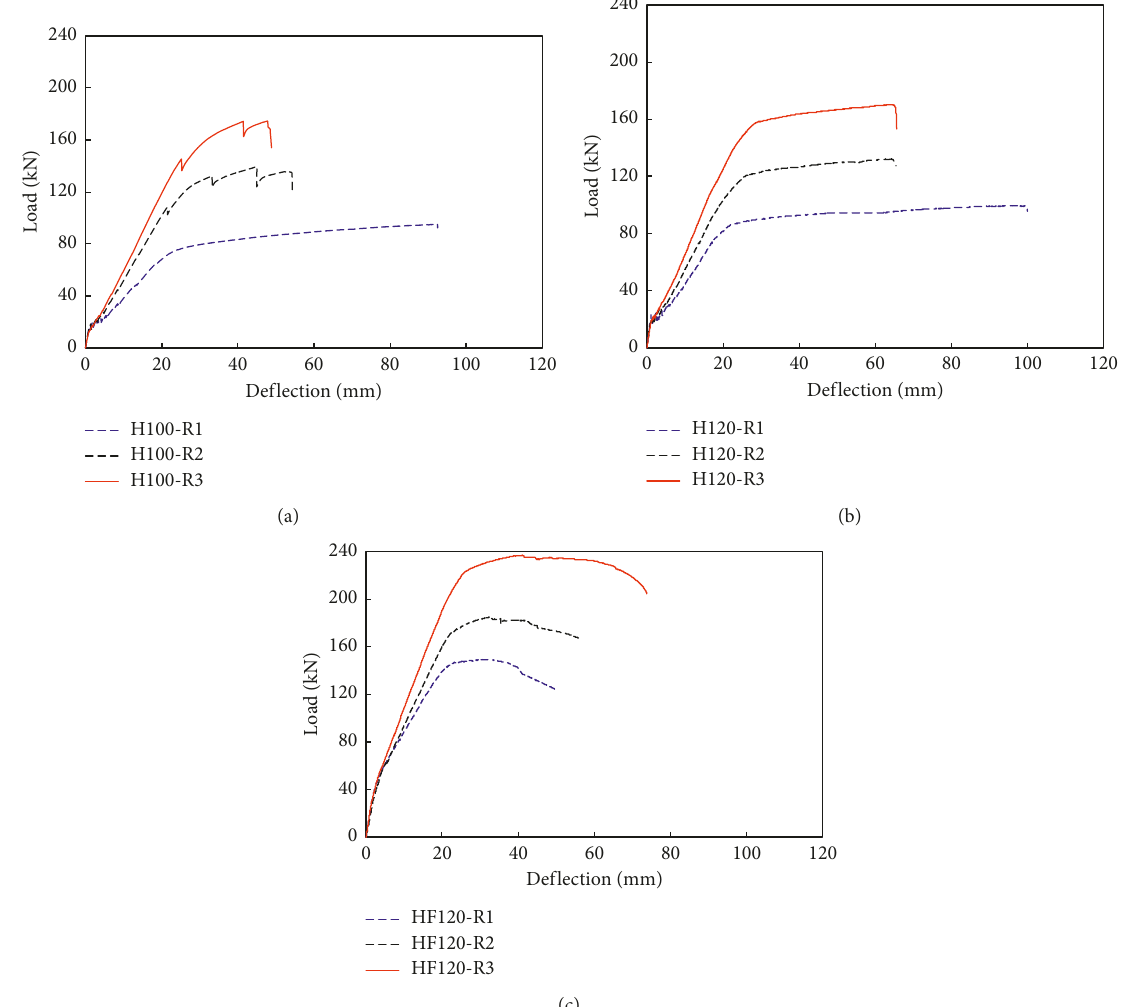
Figure 8: Load-deflection curves at different rebar ratios. (a) H100 series beams. (b) H120 series beams. (c) HF120 series